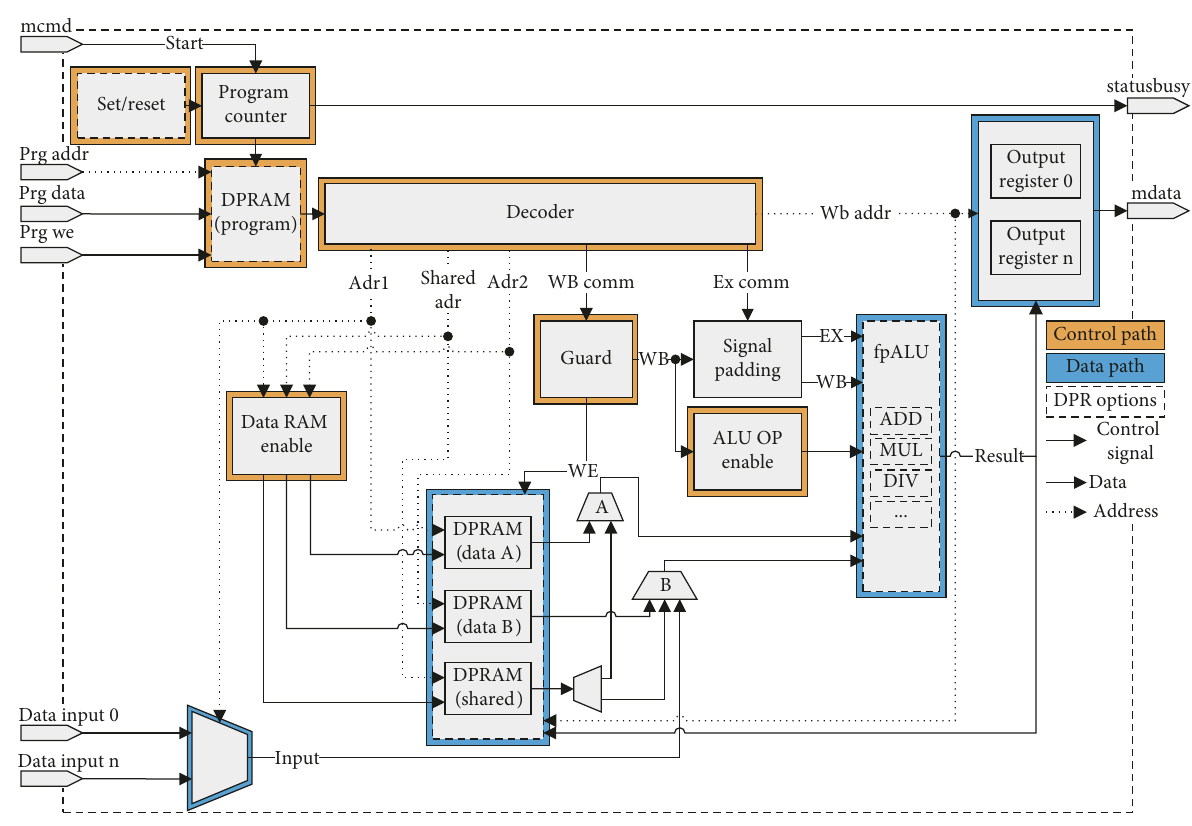
Figure 3: Schematic of one core of the ViSARD multi-soft-core processor (based on [30]).